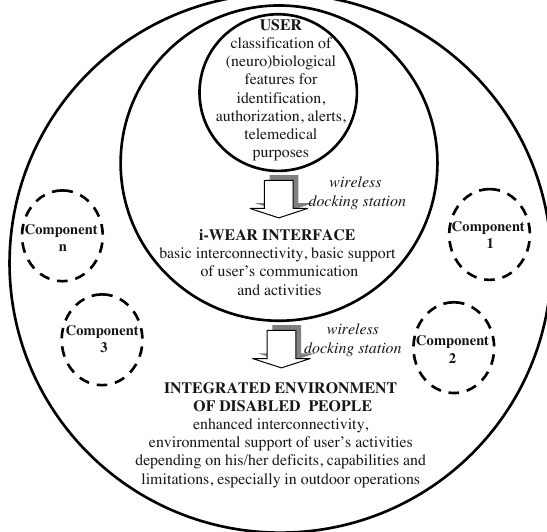
Figure 2. The concept of the user as the key part of the system